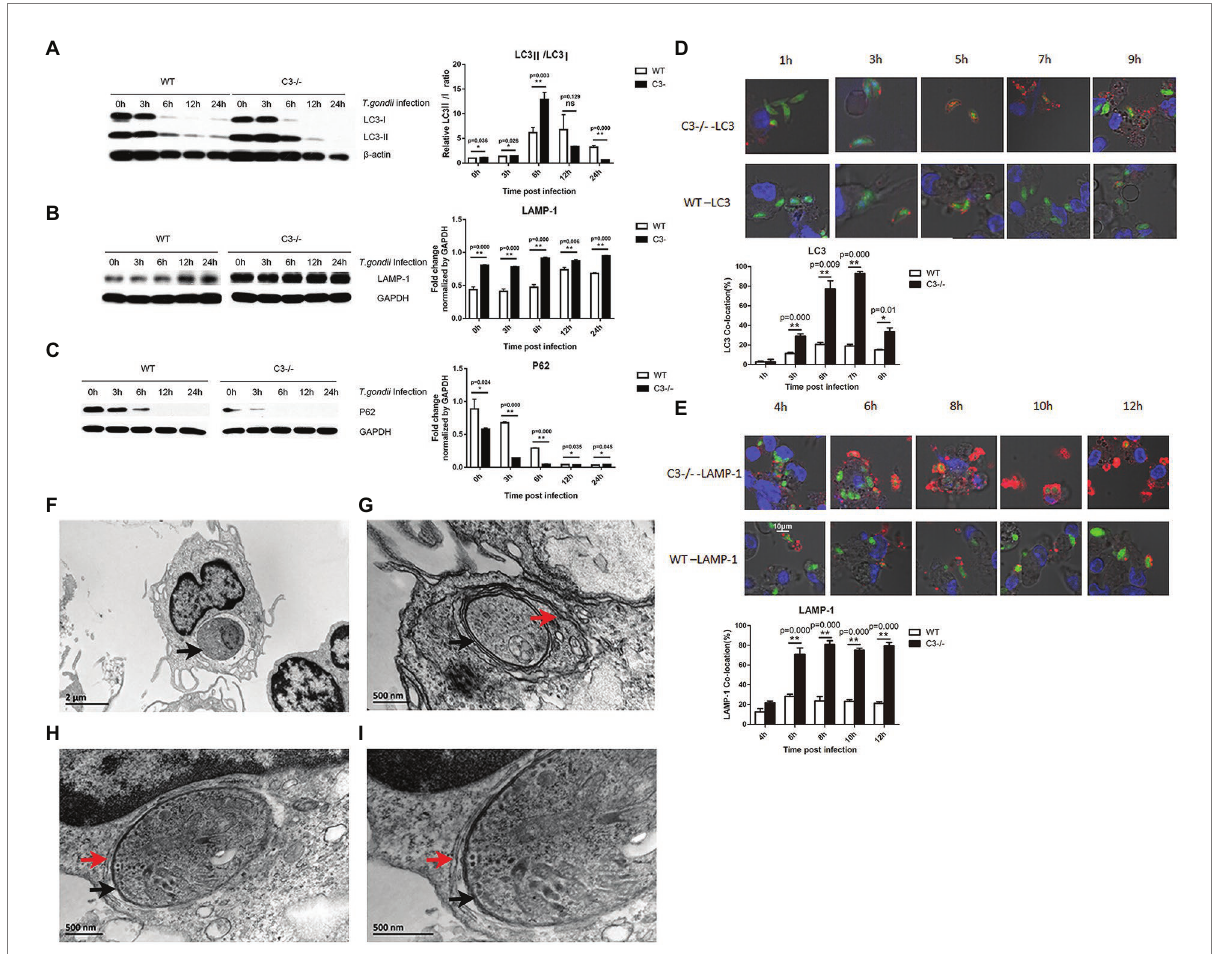
FIGURE 2 Knock-out of local complement C3 promotes the specific autophagic activity against T. gondii in macrophages. (A-C) Western blot was used to detect the effect of T. gondii infection on LC3, LAMP-1, and p62 protein expression in macrophages from C3 − / − and WT mice at 0, 3, 6, 12, and 24 h time points. Intensity was measured by ImageJ software. (D) Copolymerization ratio of LC3 with intracellular T. gondii proteins in macrophages from C3 − / − and WT mice at 1, 3, 5, 7, and 9 h time points. (E) Copolymerization ratio of LAMP-1 with intracellular T. gondii proteins in macrophages from C3 − / − and WT mice at 4, 6, 8, 10, and 12 h time points. The images were obtained by a confocal microscope. LC3 and LAMP-1 appear red fluorescence, and intracellular T. gondii proteins appear green fluorescence. Count the number of T. gondi i that are copolymerized with LC3/LAMP-1 protein (n) in 100 RH-EGFP T. gondii. LC3/LAMP-1 co-location (%) = n%. * p < 0.05, ** p < 0.01 indicates WT group vs. C3 − / − group. n = 5 in each group. Data are the mean ± SD. WT, wild-type mice’ macrophages; C3 − / − , macrophages from C57BL/6 J mice with C3 knock-out. Time points,the time for macrophages incubated with the RH-EGFP T. gondii . Scale bars, 10 μ m. (F-I) Ultrastructure of T. gondii in C3 − / − macrophages by TEM. (F) An image from a longitudinal slice of macrophages from WT mice invaded by T. gondii. G-I. An image from a transverse slice of macrophages from C3 − / − mice invaded by T. gondii. (I) is magnified from (H) . The black arrows point to the parasitophorous vacuole membrane. The red arrows point to the double-membrane vesicle structure. Scale bars, 2 μ m and 500 nm in